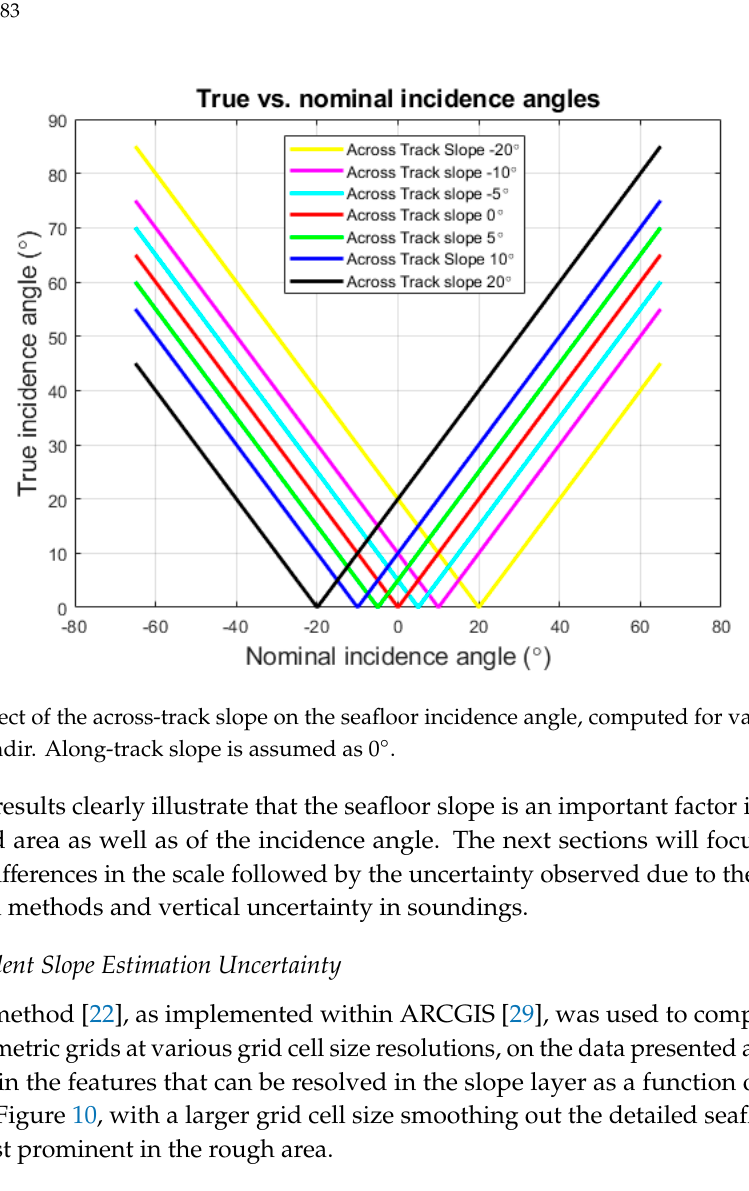
Figure 8. Effect of the along-track slope on the seafloor incidence angle, computed for various across-track, Tx , angles relative to nadir. Across-track slope is assumed as 0°.